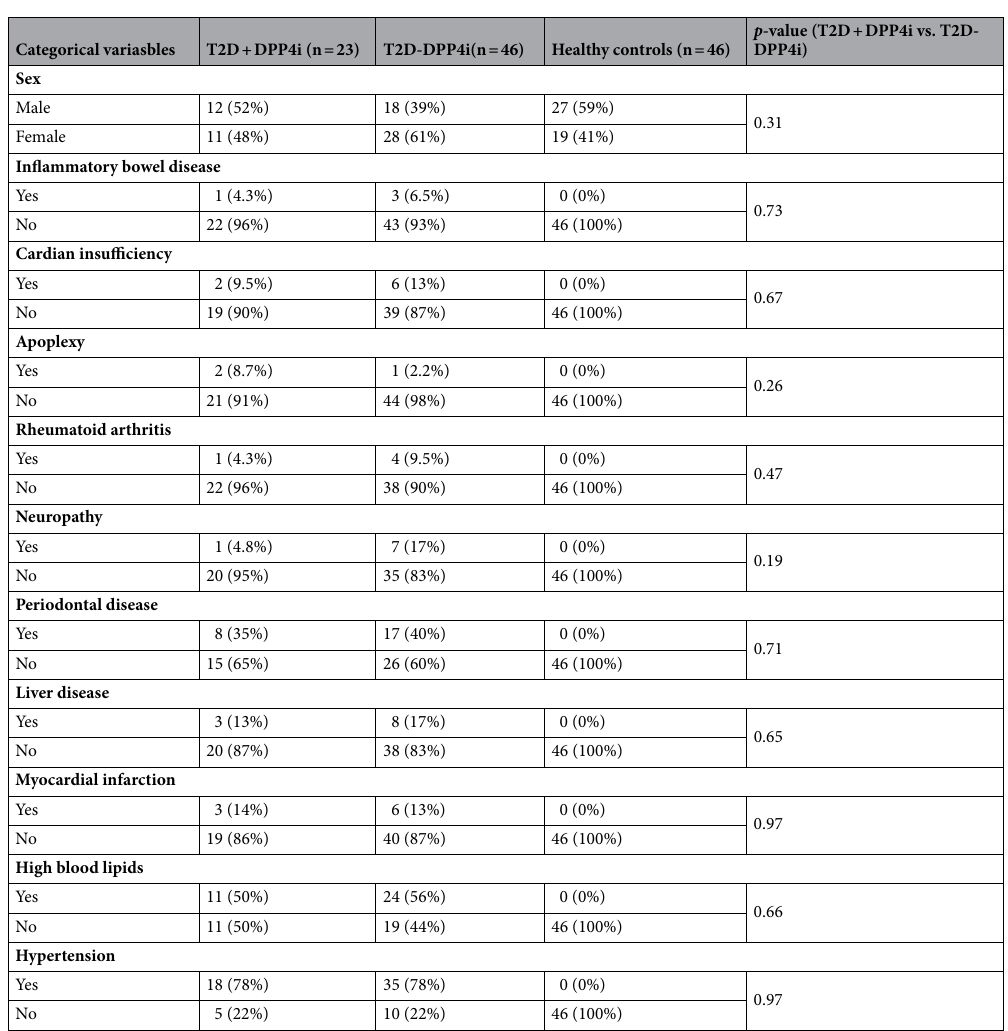
Table 2. Basic characteristics of the FoCus subcohort stratified into subjects taking DPP4i (T2D + DPP4i), without DPP4i treatment (T2D-DPP4i) and healthy controls. Values of categorical variables are shown as n (%); Subjects were matched by age and gender. Wilcoxon Test; statistical significance: p <